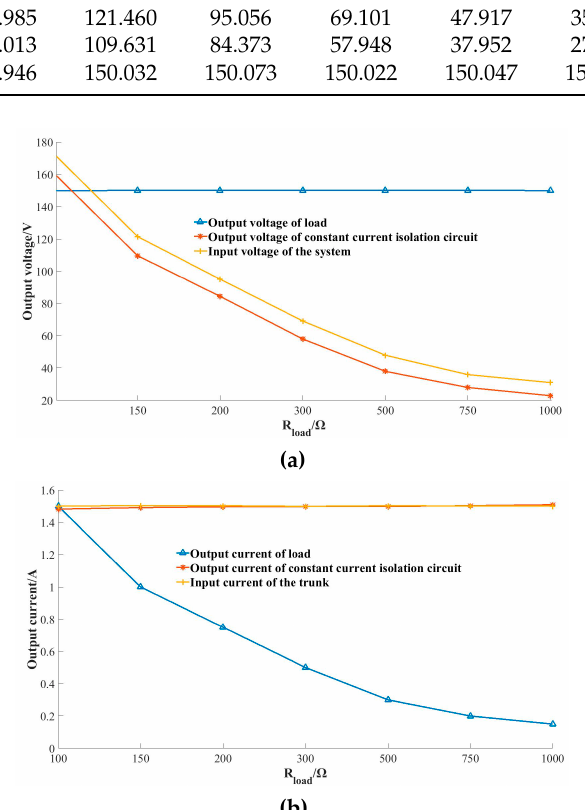
Figure 15. Curve of relationship between resistance value of load and output voltages and currents of load, CC isolation circuit and the trunk: ( a ) Curve of relationship between load and the voltages of load, CC isolation circuit and the trunk; ( b ) curve of relationship between load and the currents of load, CC isolation circuit and the trunk.